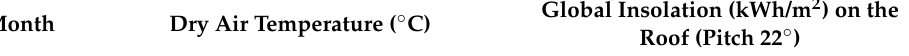
Table A1. Monthly climate data of